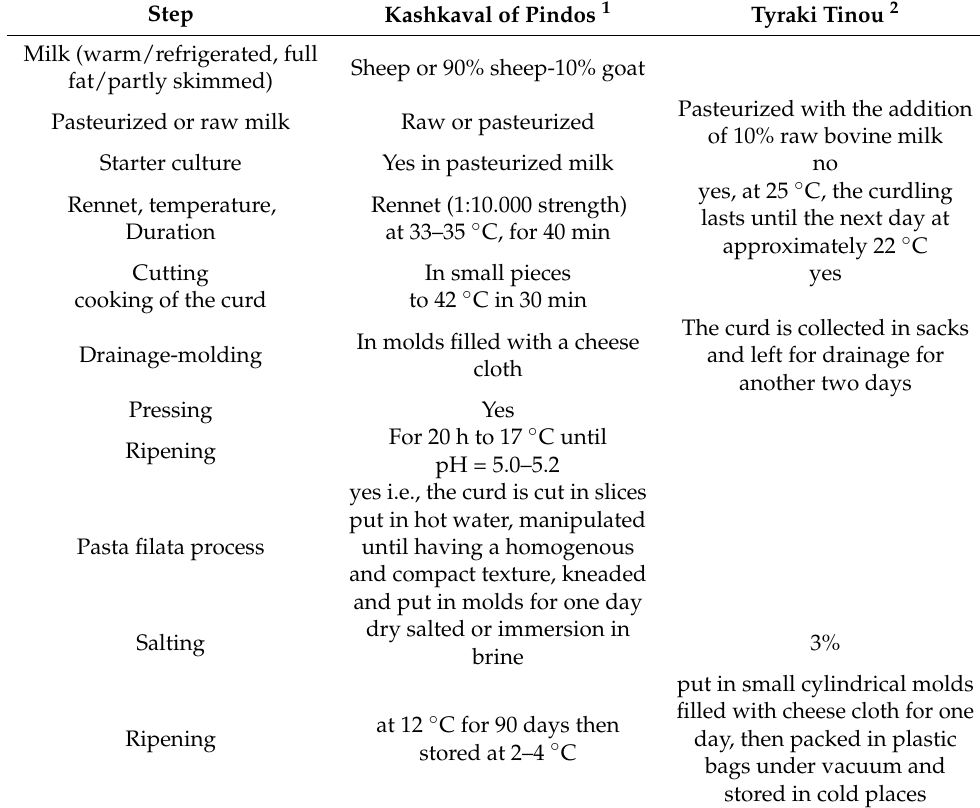
Table 5. Manufacturing technology of nonprotected designation of origin and nonprotected geo- graphical indication semihard cheeses.